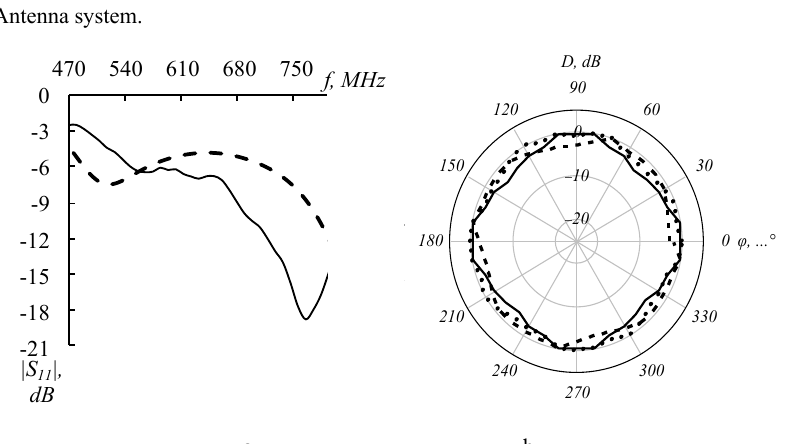
Fig. 6. Antenna system.